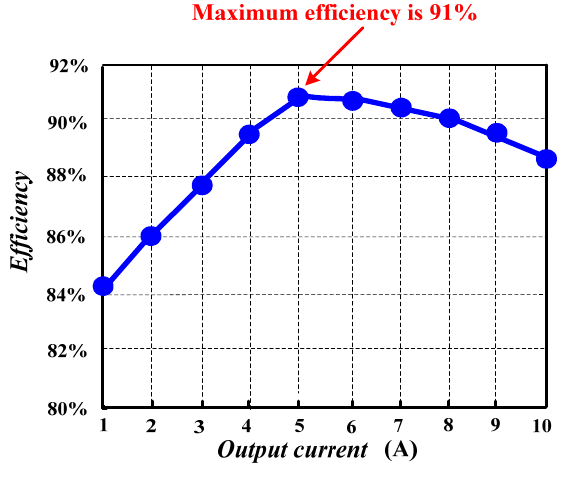
Figure 23. Plots of efficiency versus output current for the proposed dual-input power supply system with ZVS forward